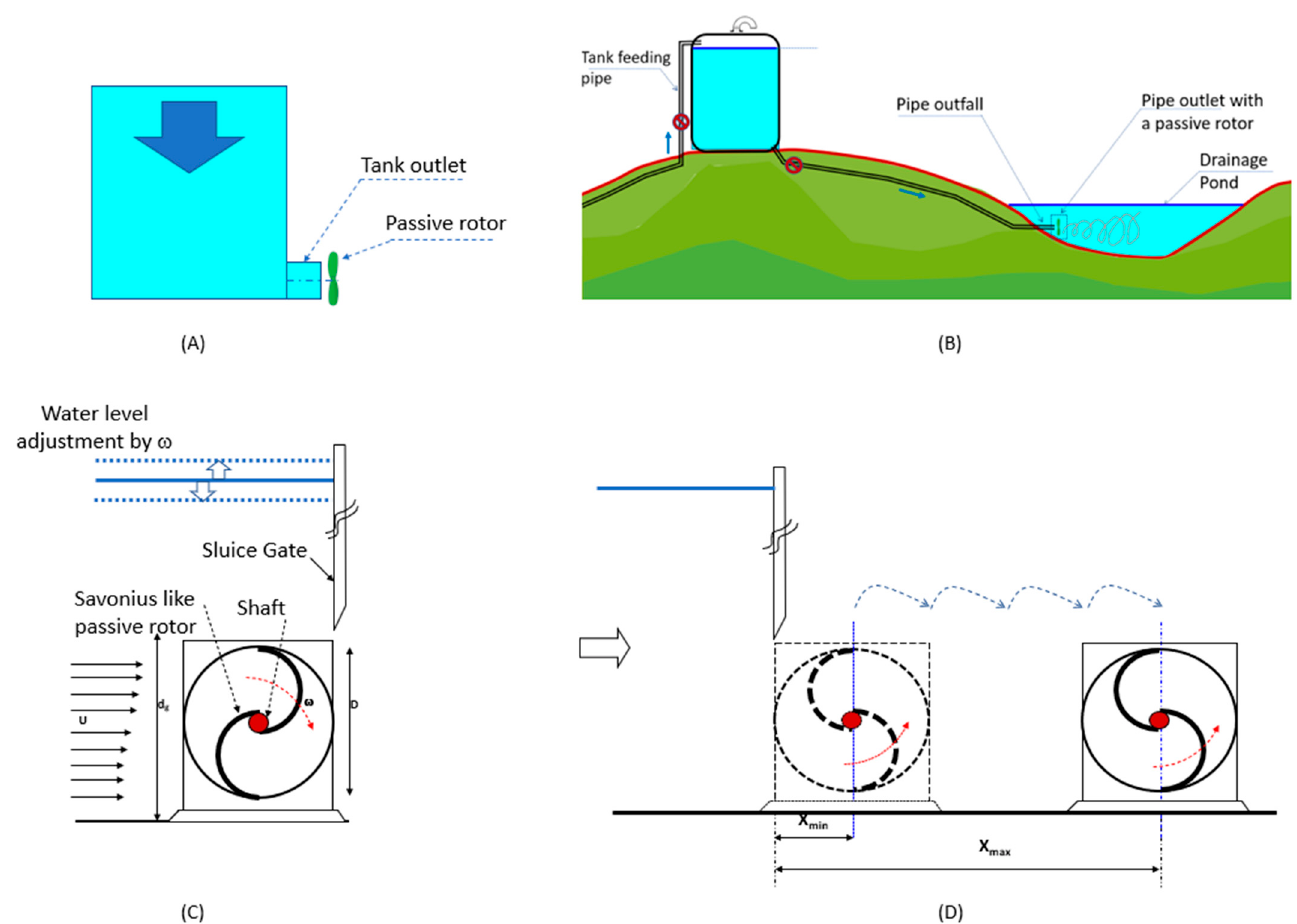
Figure 1. Samples of proposed applications where passive rotors could be utilized. ( A ) at the out- let of a drainage tank, ( B ) at the outlet of pipe outfall, ( C ) at the upstream of a sluice gate, ( D ) at the downstream of a sluice